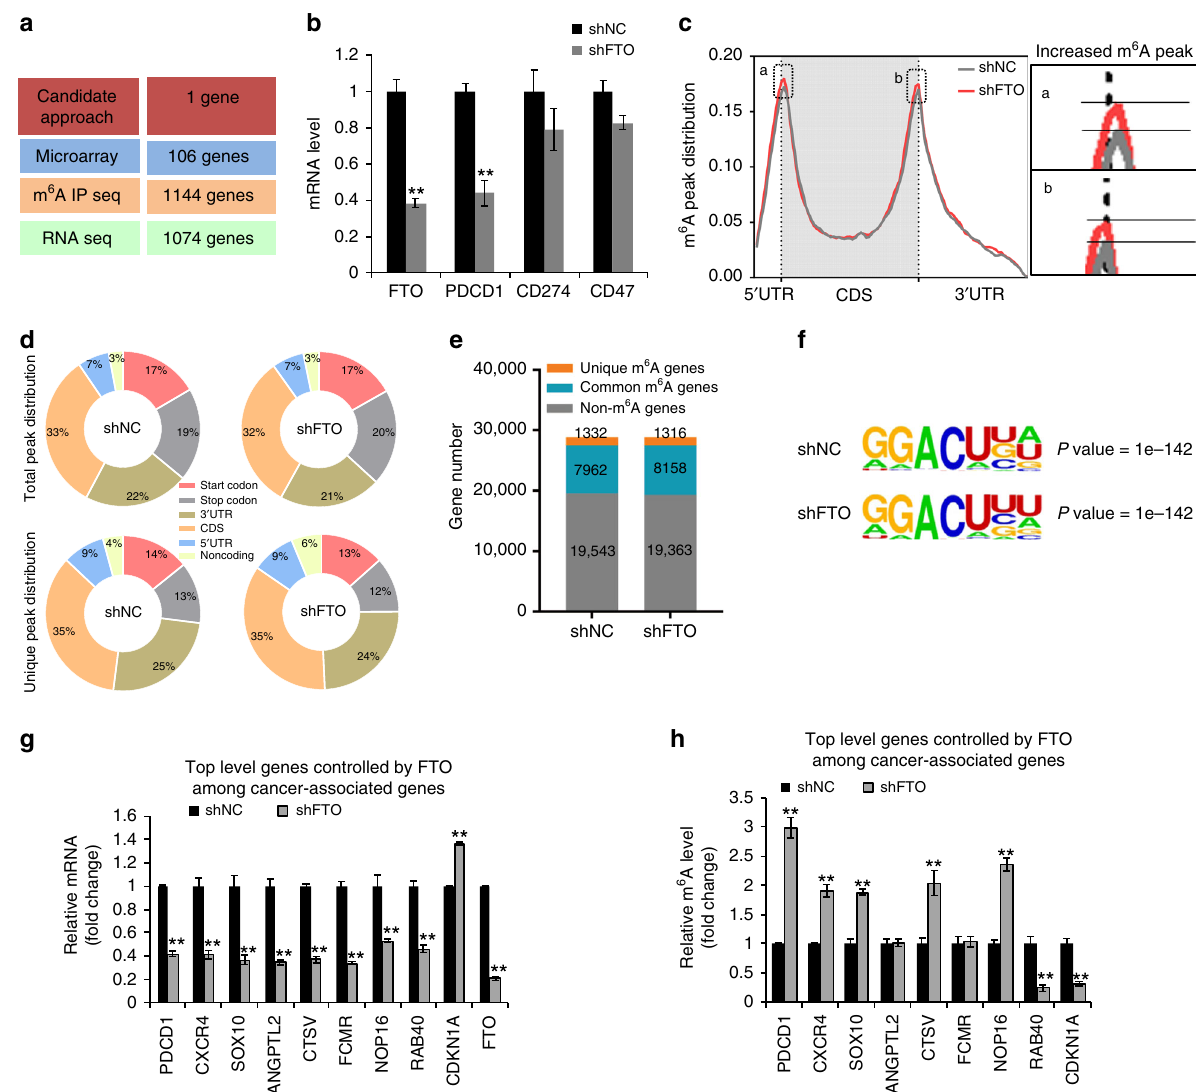
Fig. 4 Identi fi cation of potential targets of FTO in melanoma. a Schematic summary for analysis of FTO target genes and number of genes identi fi ed. b Relative expression of FTO, PD-1 (PDCD1), CD274, and CD47 in Mel624 cells with or without FTO knockdown. c Distribution of m 6 A peaks across the length of mRNA. Region of 5-untranslated region (5 ′ UTR) was binned into 10 segments, coding region (CDS) was binned into 50 segments, and 3- untranslated region (3 ′ UTR) was binned into 40 segments, and the percentage of m 6 A peaks that fall within each bin was determined. d The proportion of m 6 A peak distribution in the indicated regions across the entire set of mRNA transcripts (top) and the appearance of new m 6 A peaks (unique peaks in shFTO), or loss of existing m 6 A peaks (unique peaks in shNC) after FTO knockdown (bottom). e Number of m 6 A-modi fi ed genes identi fi ed in m 6 A-seq in shNC and shFTO Mel624 cells. Common m 6 A genes contain at least one common m 6 A peak, while unique m 6 A genes contain no common m 6 A peaks. f Top consensus m 6 A motif identi fi ed by HOMER with m 6 A peaks in Mel624 cells with or without FTO knockdown. g qPCR analysis of mRNA levels of genes in Mel624 cells with shNC or shFTO. h Gene-speci fi c m 6 A qPCR analysis of gene-speci fi c m 6 A enrichment in Mel624 cells with shNC or shFTO. Data are shown as mean ± S.E. ( n ≥ 3). * P < 0.05; ** P < 0.01; *** P < 0.001; Student ’ s t